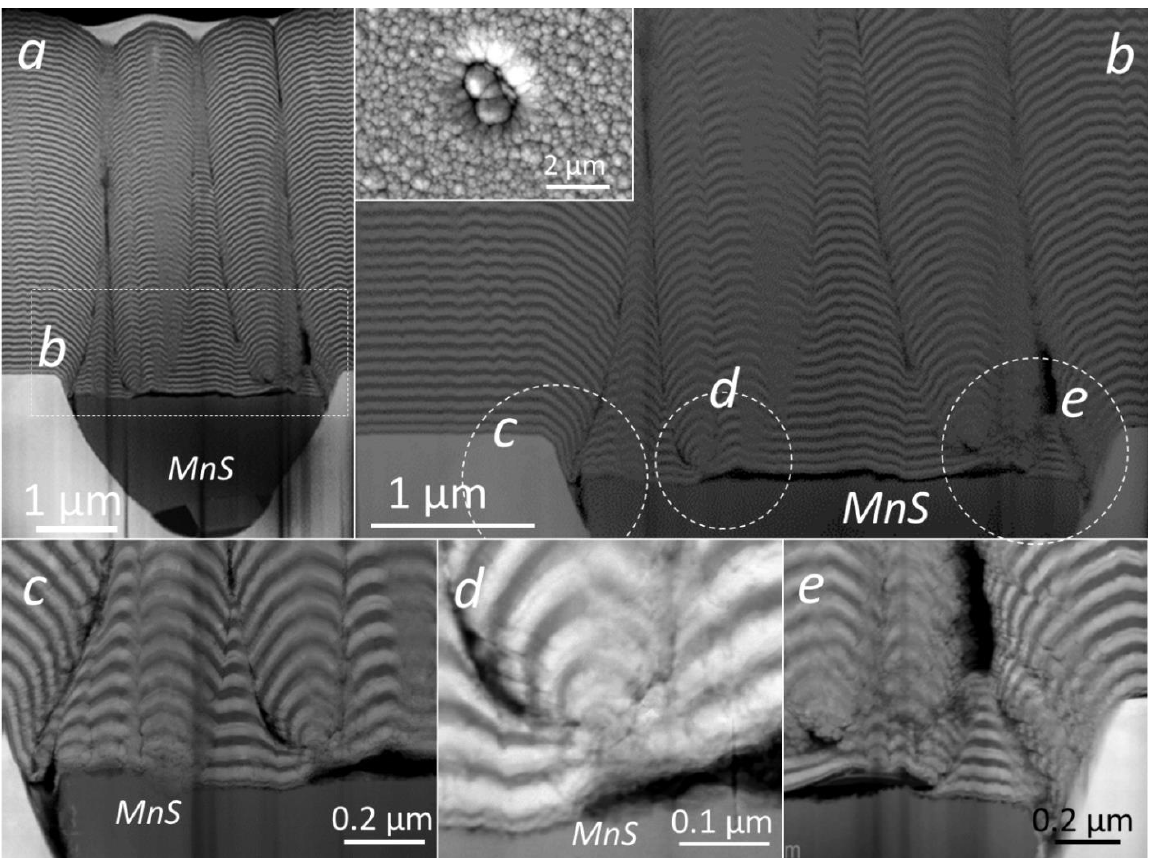
Figure 12. STEM images of the FIB cross-section of the NL-TiAlN/CrN hard coating at the site of a MnS inclusion in the stainless steel SS316L substrate ( a – e ). A shallow crater ( a ), which is formed at this site after booster ion etching, is the starting point for a pinhole formation at the boundary between the inclusion and the matrix. An additional effect is poor contact of the coating to the inclusion surface. We can also see nodular defects that have formed on smaller seed particles located at the bottom of the crater ( c , d , e ).